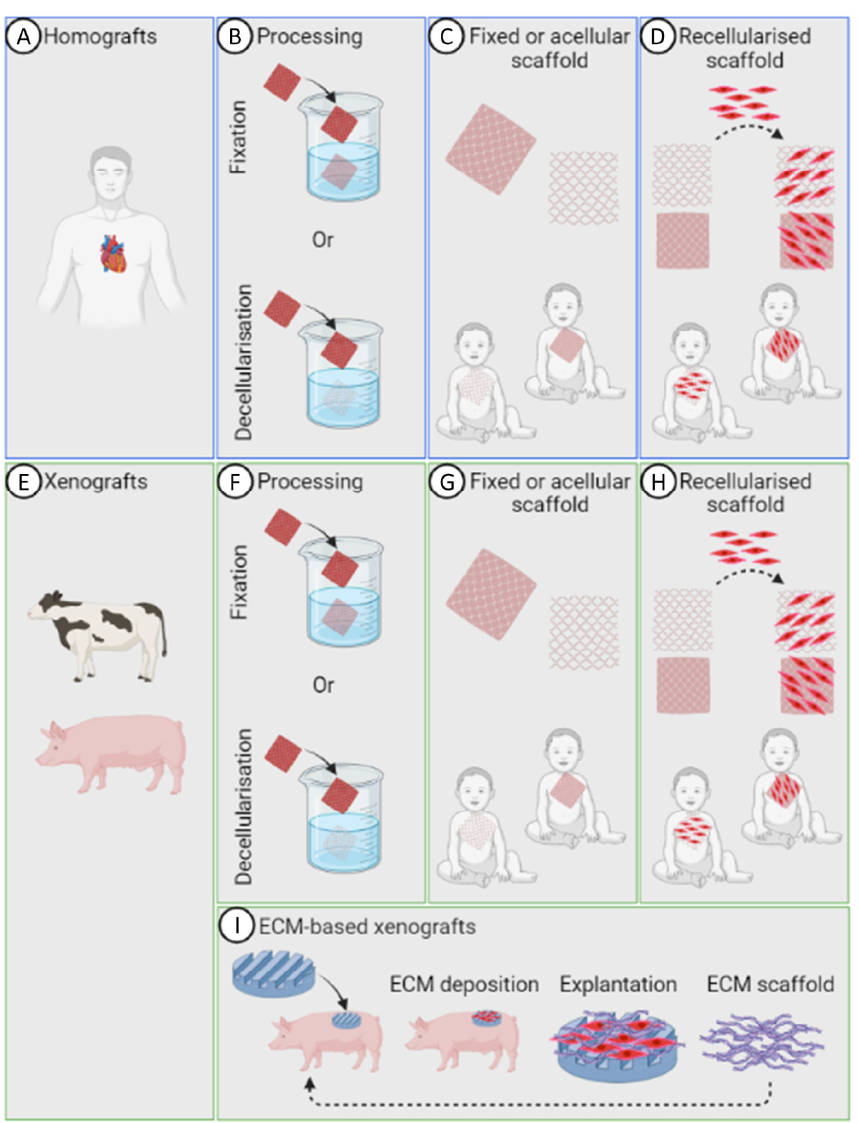
Figure 2. Schematic representation of biological scaffold production for CHD. ( A ) Tissues from human (patient donors or cadavers) origin are collected to be used as homografts. ( B ) Tissues require processing by either fixation or decellularisation to reduce antigenicity and avoid rejection by the host. ( C ) Processed materials can be used as fixed or acellular scaffolds in the clinic, or recellularised ( D ) with autologous or allogenic cells prior to implantation in CHD patients. ( E ) Tissues animal (e.g., bovine, swine, ovine, etc.) origin are collected to be used as xenografts. ( F ) Tissues require processing by either fixation or decellularisation to reduce antigenicity and avoid rejection by the host. ( G ) Processed materials can be used as fixed or acellular scaffolds in the clinic, or recellularised. ( H ) with autologous or allogenic cells prior to implantation in CHD patients. ( I ) Production of ECM-based grafts involves percutaneous implantation of a synthetic non-biodegradable scaffold, which acts as a mould for ECM deposition. The mould with the deposited tissue will be explanted and the ECM, having been physically separated from the mould, used as an autologous ECM-based graft in the original host. Different sources of homografts include tissue obtained from the pericardium, decellularised cardiac tissues, AM, and ECM [84]. Cardiovascular dECM such as pericardium, myocardium, and pulmonary artery tissue could be used as potential sources for cardiovascular therapeutic applications in paediatric CHD. Site-specific dECM scaffolds exhibit the same composition and spatial arrangement of ECM constituents as the target tissue, allowing adequate cell–cell interactions to occur and paving the way towards tissue morphogenesis and thus repair and regeneration of the heart [85,86].